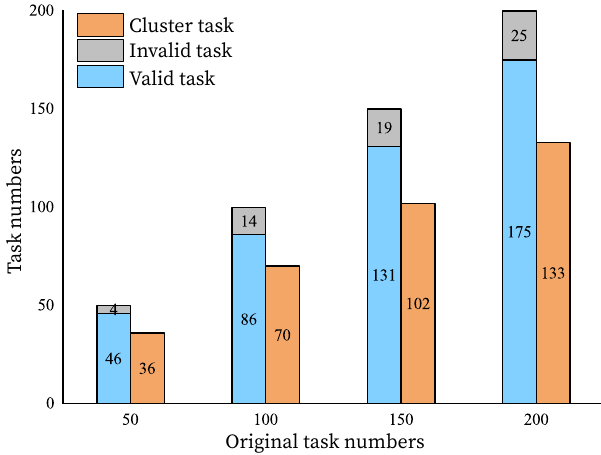
Figure 9. Performance demonstration of clustering algorithm.